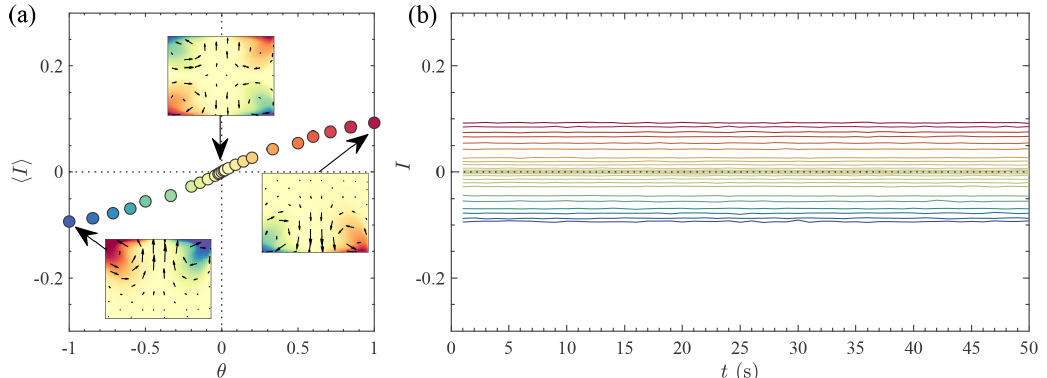
Figure 9. Seasonal cycle in the von Kármán experiment for a reduced number of degrees of freedom – using glycerol. (a) Mean angular response (cid:104) I (cid:105) to the forcing asymmetry. (b) Instantaneous vertical angular momentum response for a fixed θ coloured according to θ with the colour choices of (a)